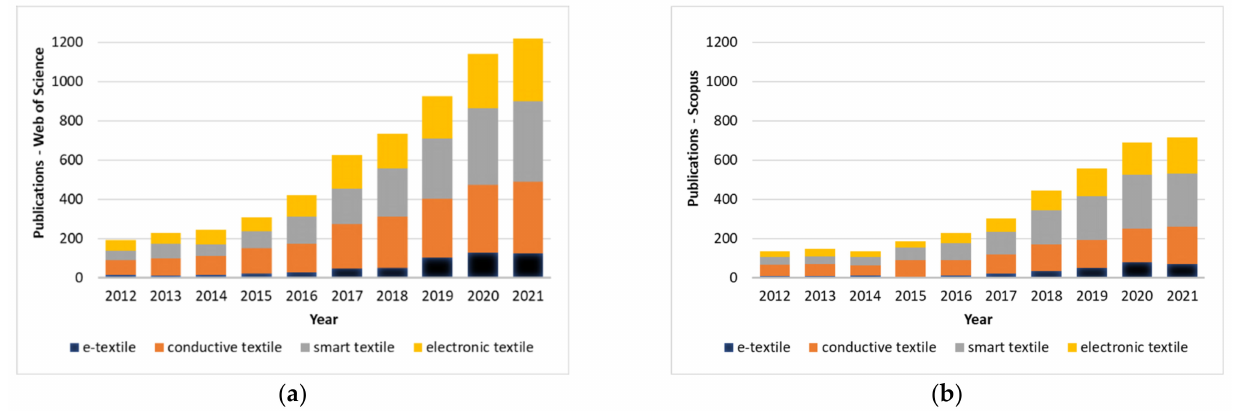
Figure 1. Published scientific articles from 2012 up to 2021 using four keywords: “e-textile”, “conduc- tive textile”, “smart textile” and “electronic textile”: ( a ) Web of Science; and ( b )